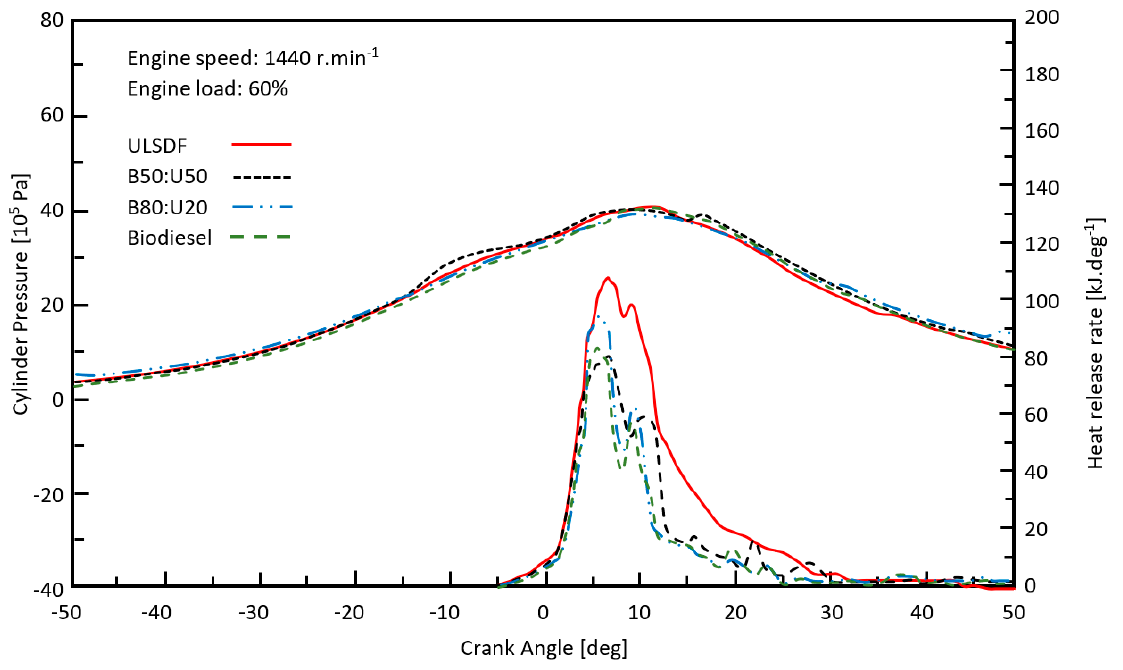
Figure 6 . Tested fuels’ influence on the heat release rate and cylinder pressure at 1440 rpm and 60% load .